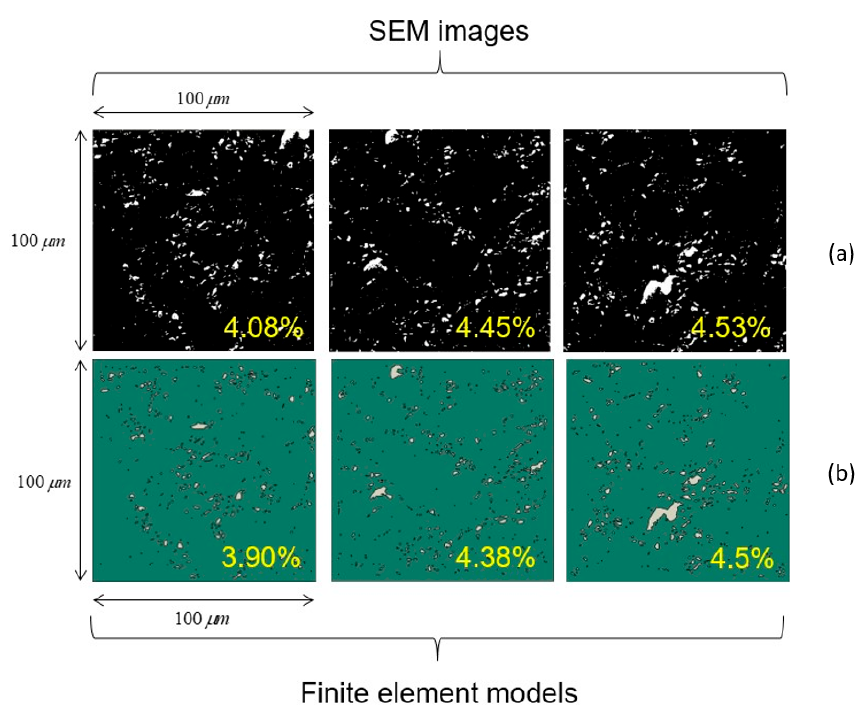
Figure A1. Comparison between particle area fractions computed for the ( a ) original SEM image and ( b ) unit cell representation.